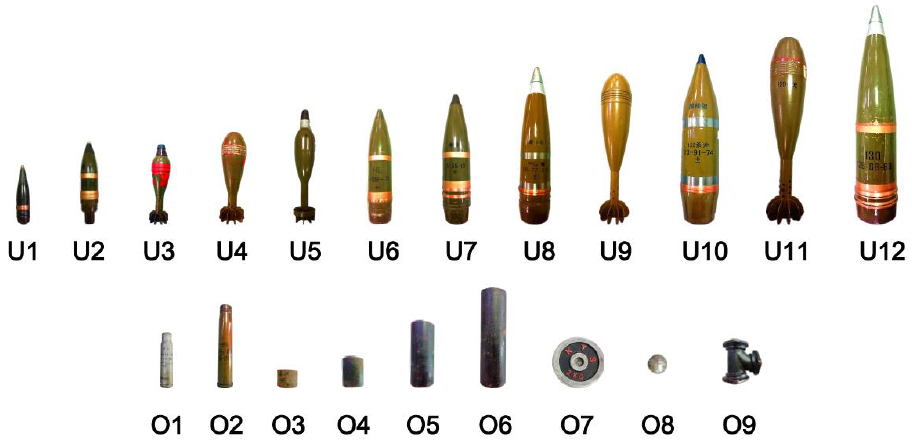
Figure 7. Target detection and data processing.